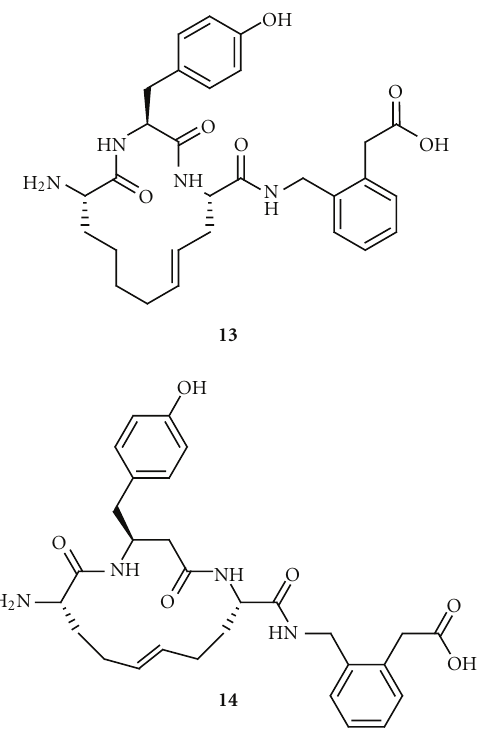
Figure 13: Macrocyclic Ang IV peptidomimetics that strongly inhibit